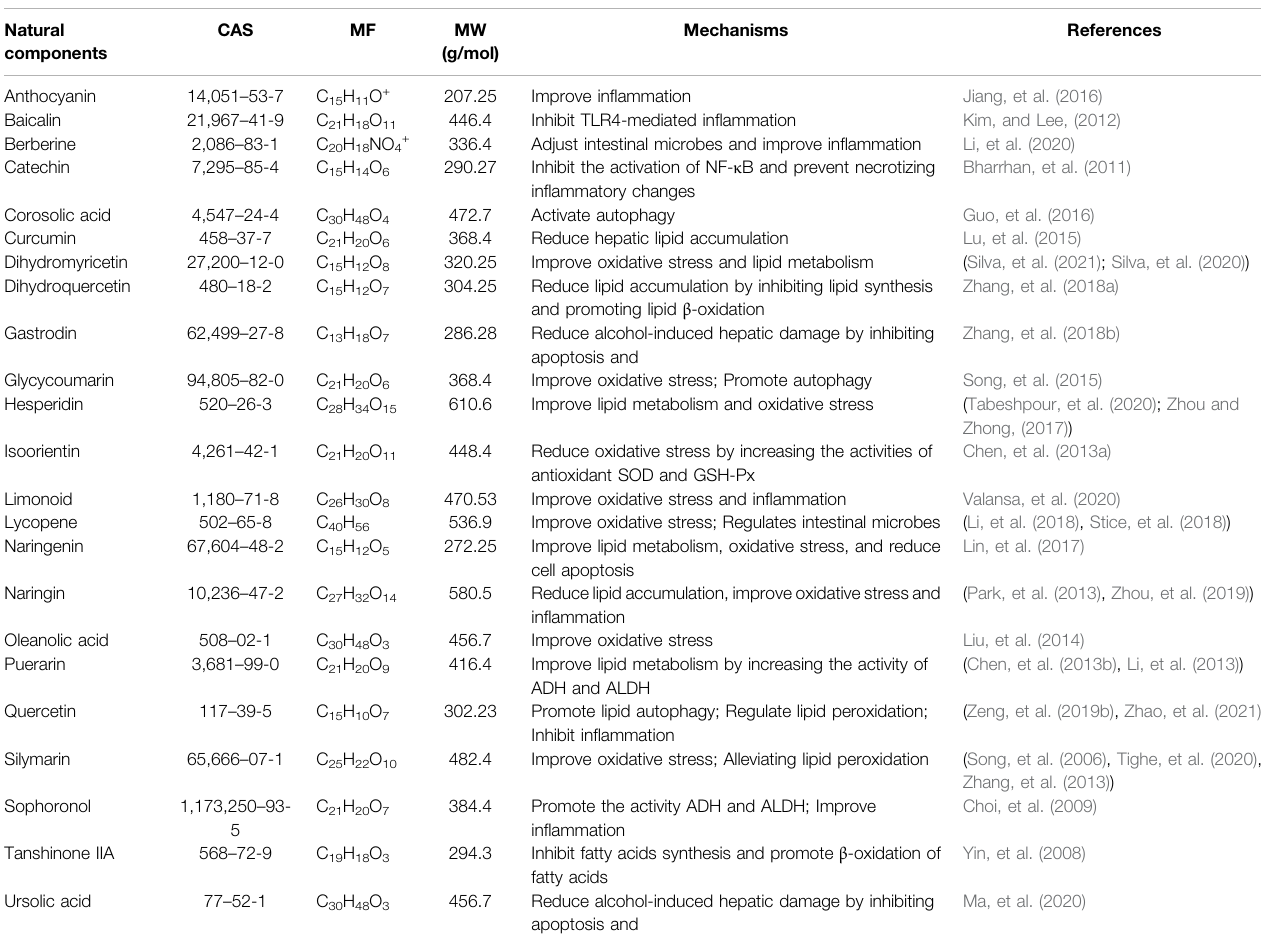
TABLE 1 | | Natural compound derived from herbs for the potential treatment for